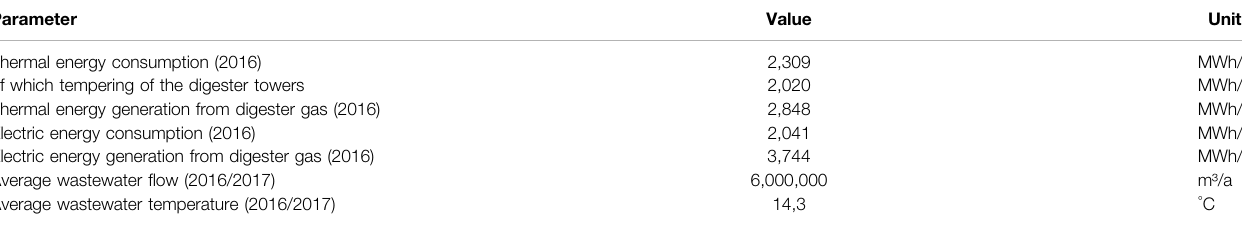
TABLE 9 | Key technical and operational data of the case study WWTP (Zach et al., 2019 adapted). Parameter Value Thermal energy consumption (2016) of which tempering of the digester towers Thermal energy generation from digester gas